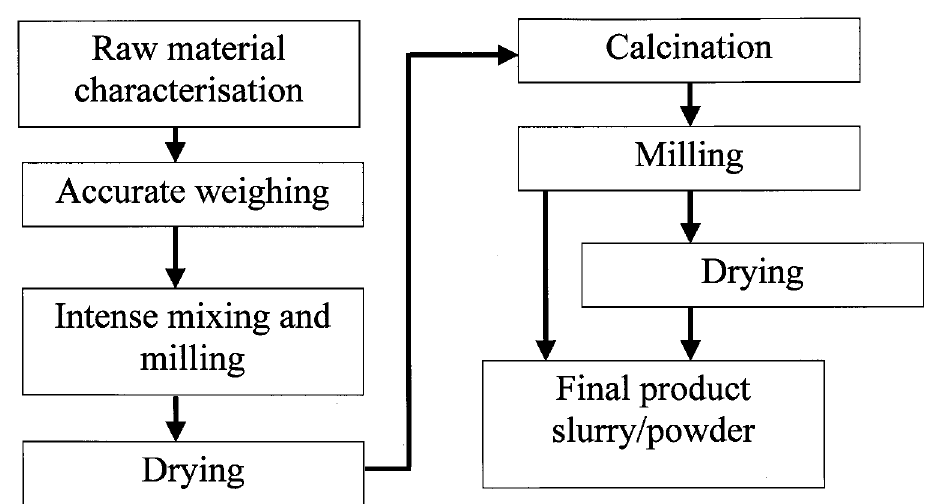
FIGURE 1 Mixed oxide material